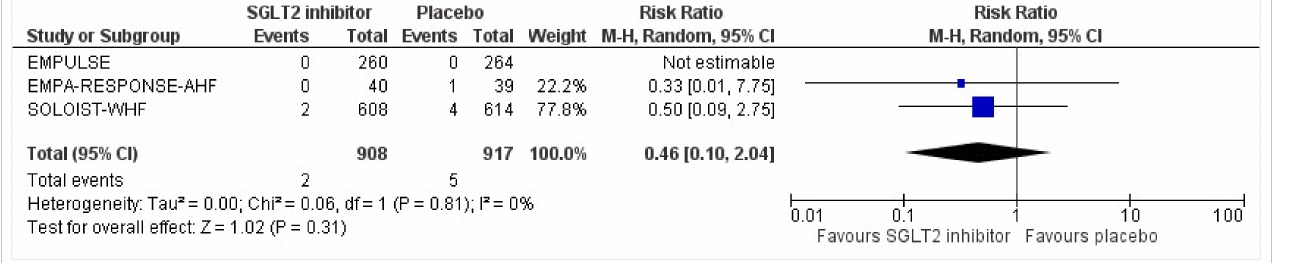
Figure 13. Forest plot for the total number of patients who had DKA as a serious adverse event in either group [25–27].